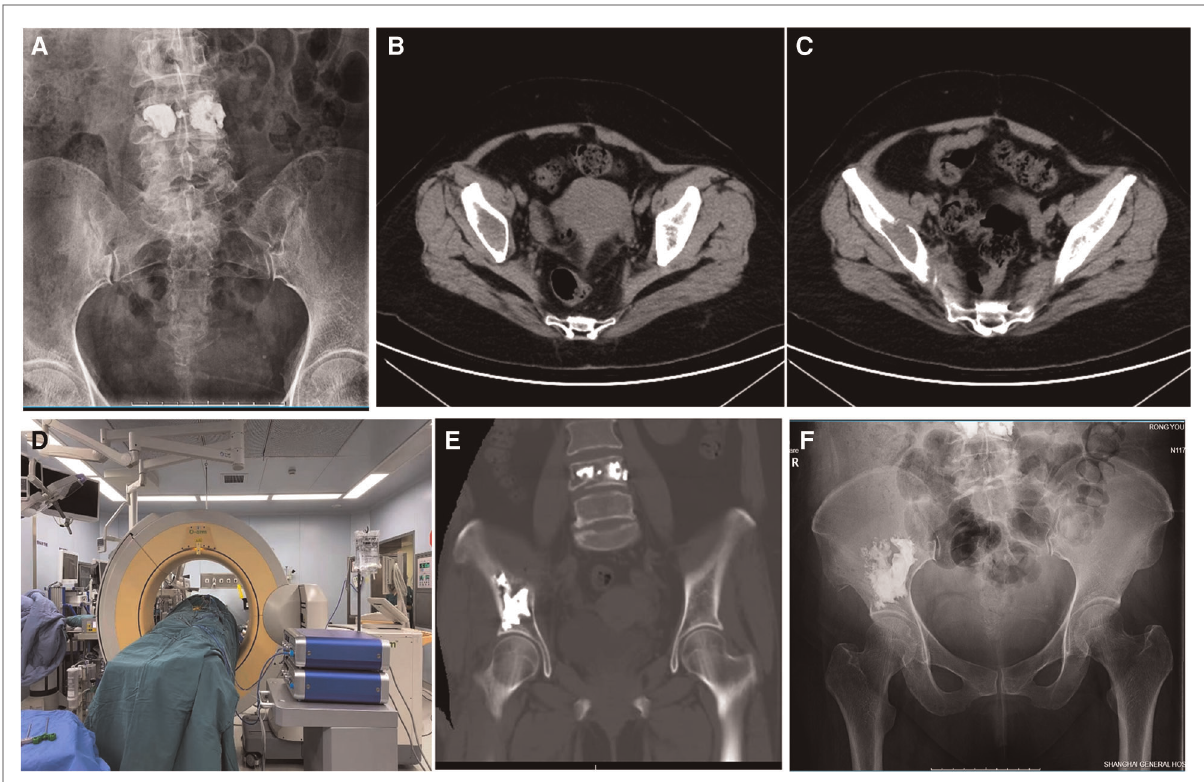
FIGURE 2 59-year-old man with metastatic liver carcinoma and a painful pelvic metastasis. ( A ) Preoperative pelvic x-ray. ( B,C ) Preoperative pelvic CT scan. ( D ) Intraoperative O-arm 3D image during puncture and cementoplasty. ( E ) Postoperative pelvic CT scan. ( F ) Postoperative pelvic x-ray 6 months after the